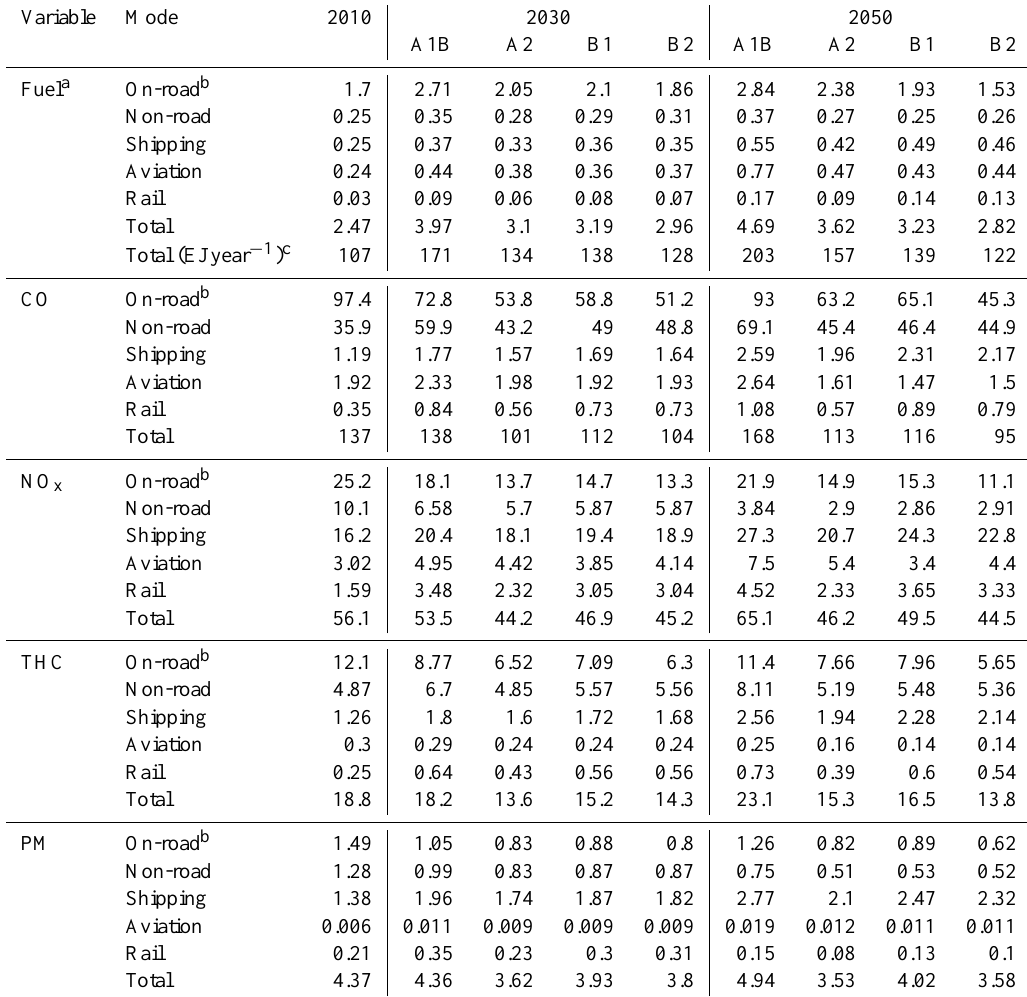
Table 6. Fuel consumption (unit: Pgyear − 1 ) and emissions (unit: Tgyear − 1 ) from different transport modes in year 2010, 2030, and 2050. Variable Mode Fuel a